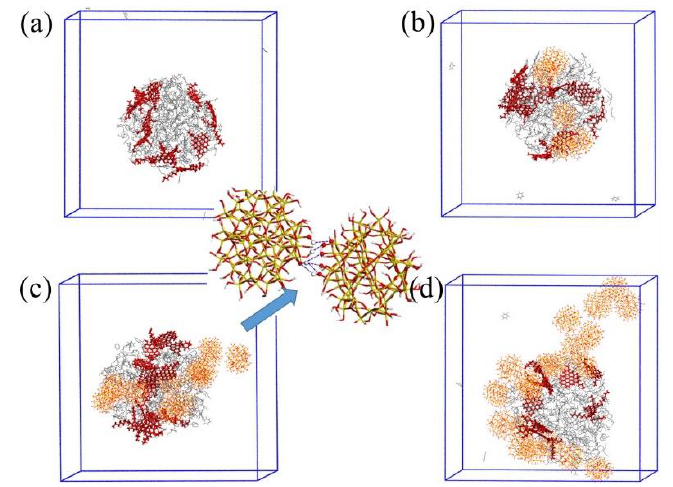
Figure 4. Snapshot of four systems in the last frame of NVT simulation. ( a ) System E-I without SNPs, ( b ) System E-II with five SNPs, ( c ) System E-III with ten SNPs, ( d ) System E-IV with twenty SNPs. In order to maintain the integrity of oil droplets, we placed the oil droplets in the center of boxes.